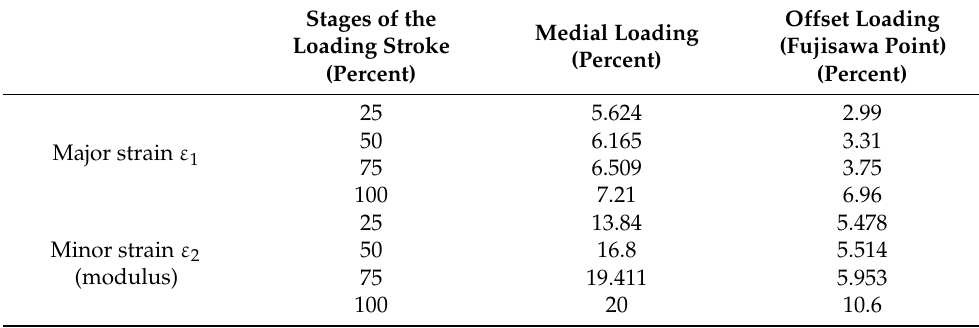
Table 1. Values of major strain ε 1 and minor strain ε 2 during medial and offset loading corresponding to a stroke of 25% (a), 50% (b), 75% (c), 100% (d) of the total loading stroke. Stages of the Offset Loading Medial Loading Loading Stroke (Percent) (Percent)